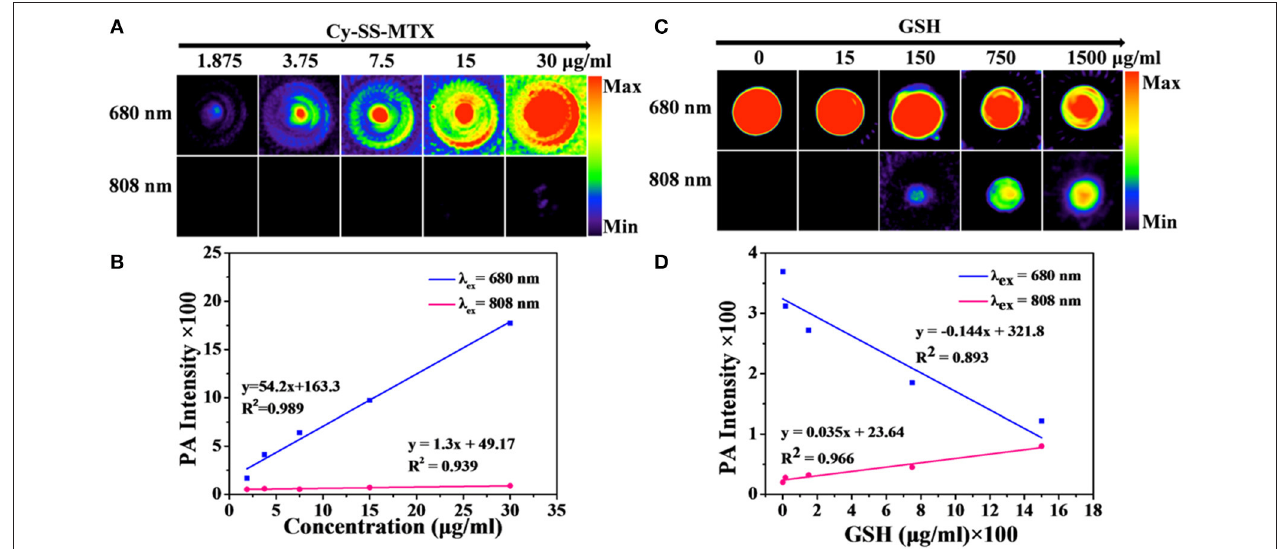
FIGURE 3 | (A) PA imaging of Cy-SS-MTX with varying concentration of Cy-SS-MTX upon excitation at 680 and 808nm respectively. (B) The intensity of PA imaging with varying concentration of Cy-SS-MTX shown in (A) . (C) PA imaging responses of Cy-SS-MTX to GSH upon excitation at 680 and 808nm respectively. (D) The intensity of PA imaging with varying concentration of Cy-SS-MTX shown in (C) .